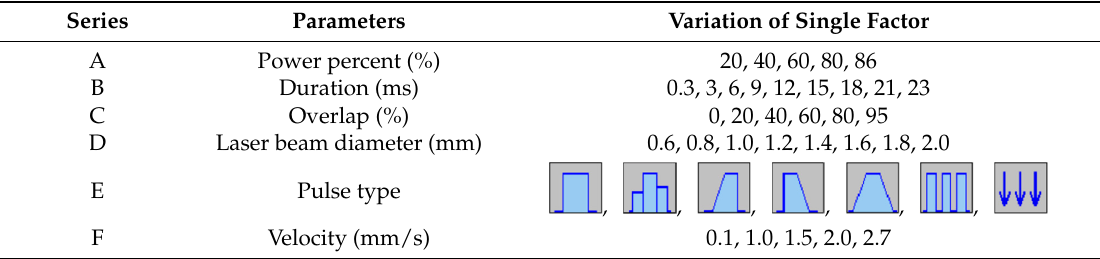
Table 3. Design of experiments for welding parameters.